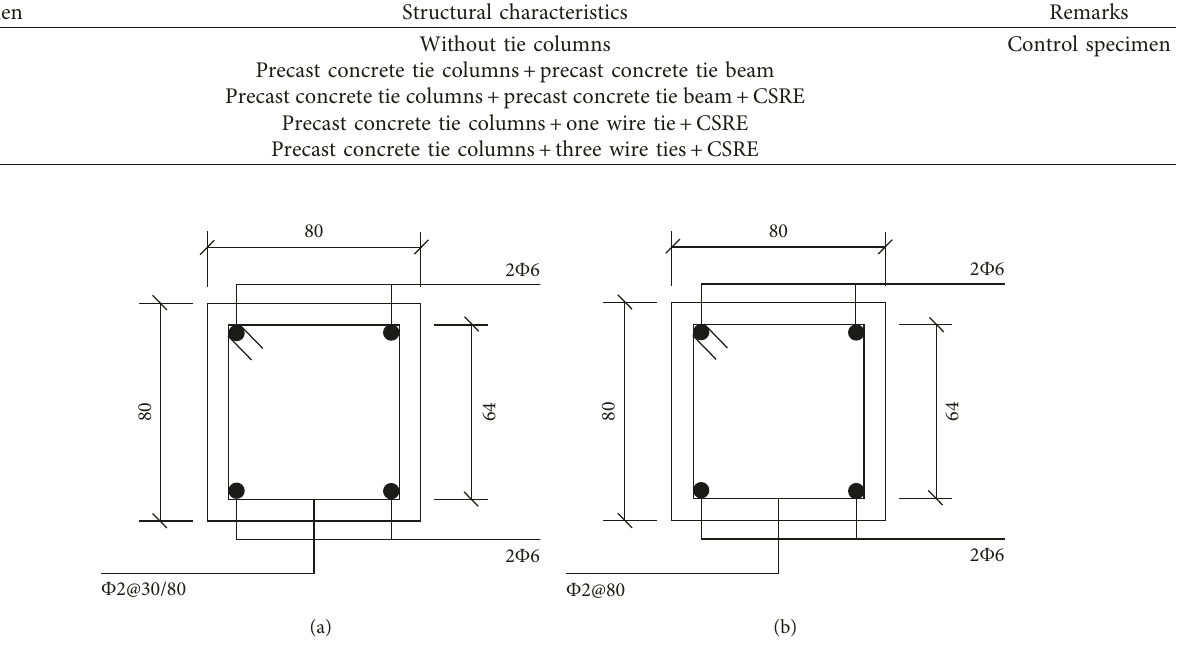
Figure 2: Details of the precast concrete tie column (a) and tie beam (b).